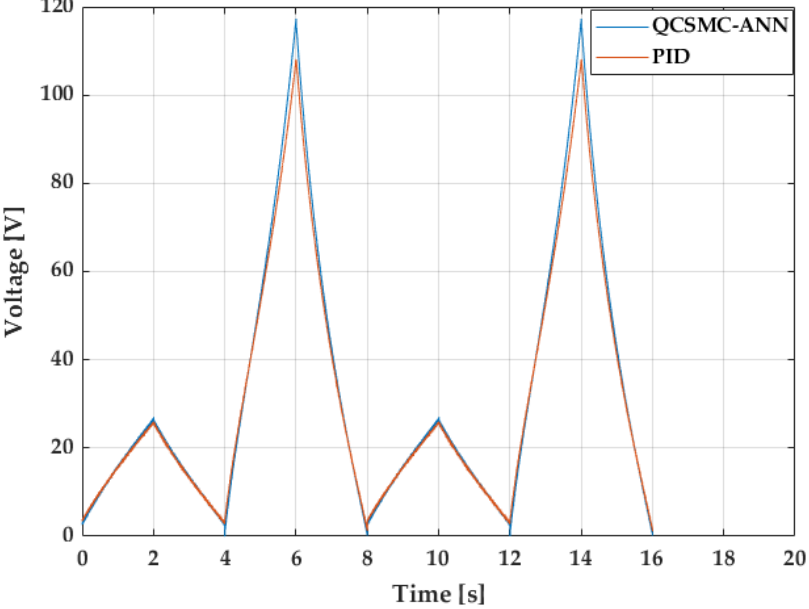
Figure 11. The control signal in 2 cycles of a triangular reference with variable